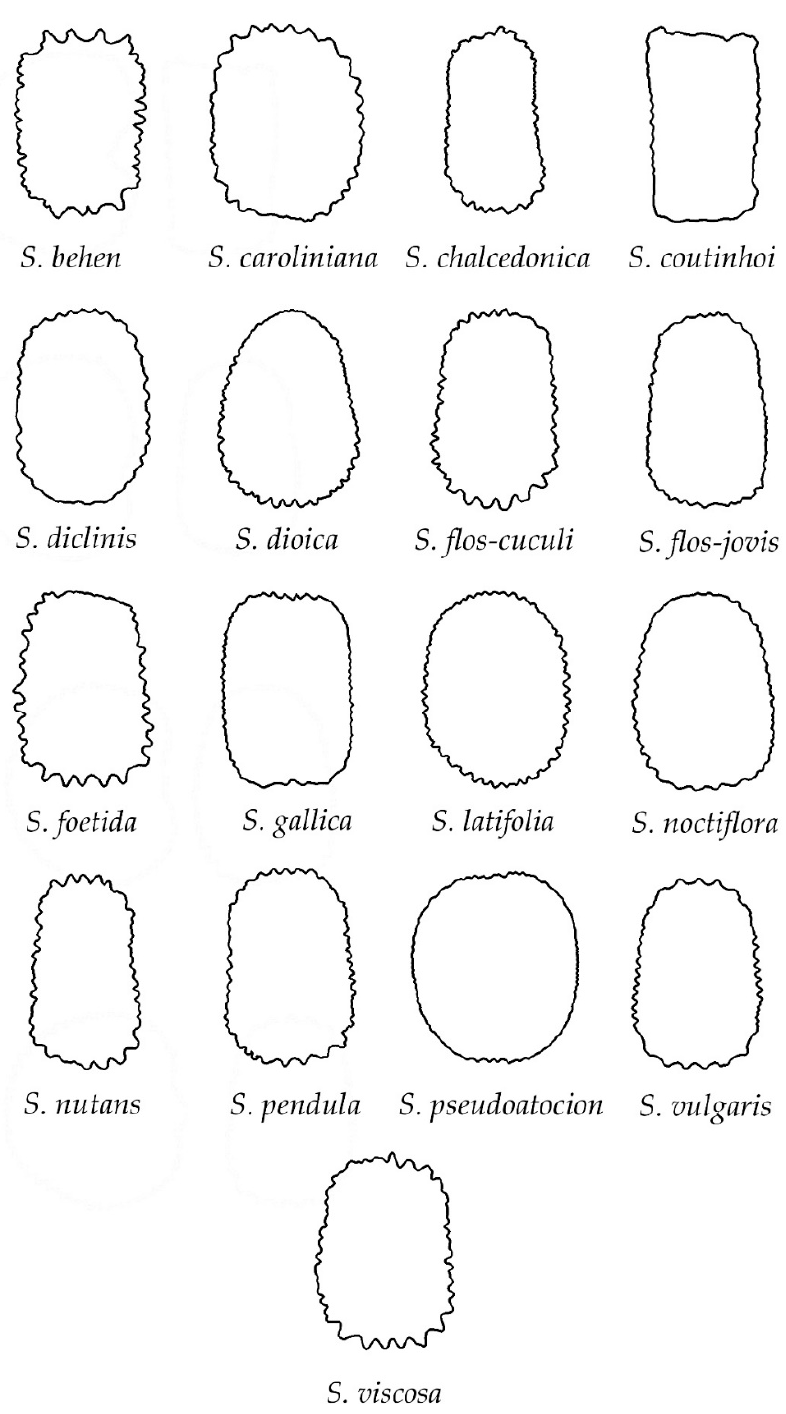
Figure 7. Silhouettes of the dorsal views of Silene seeds belonging to the group of echinate